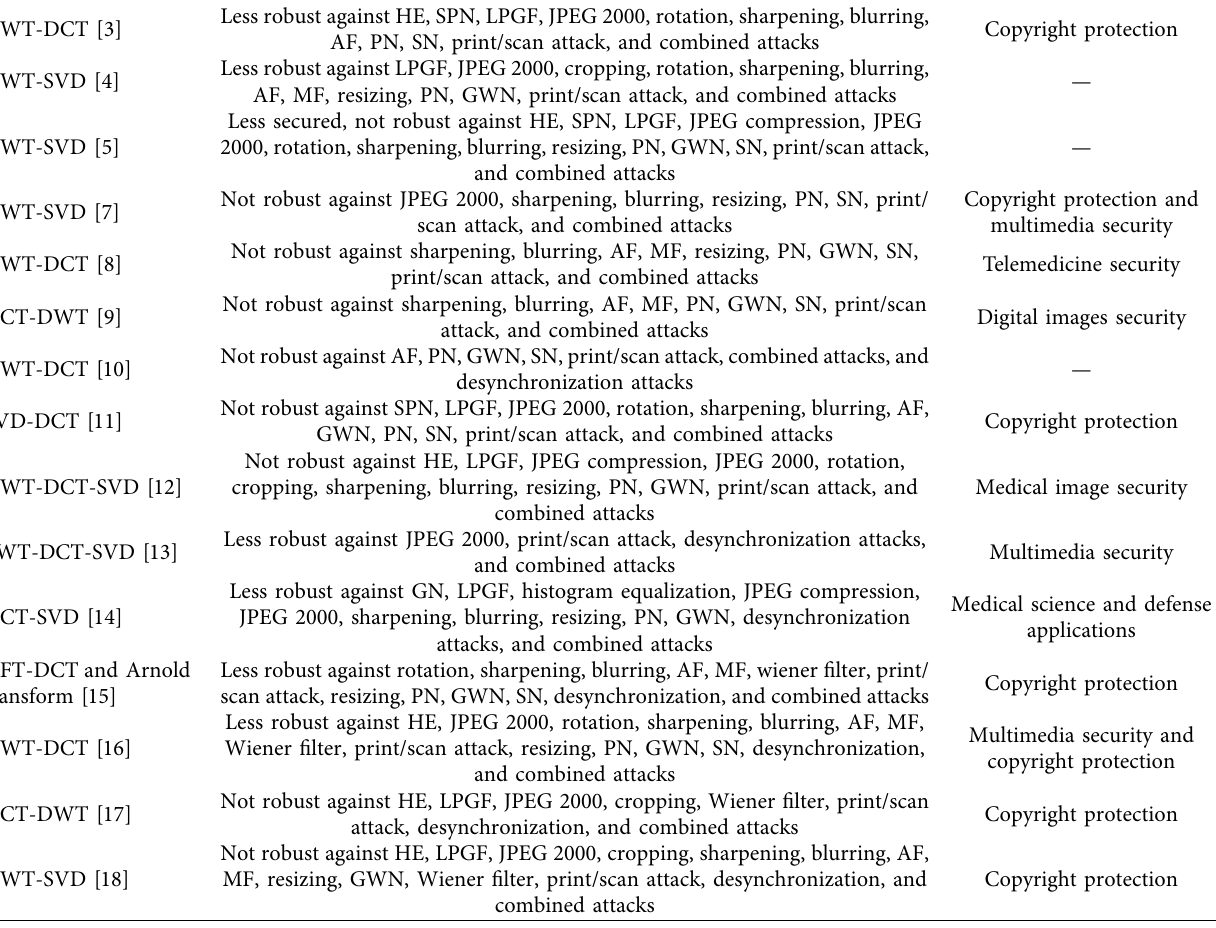
Table 5: Limitations and applications of various hybrid